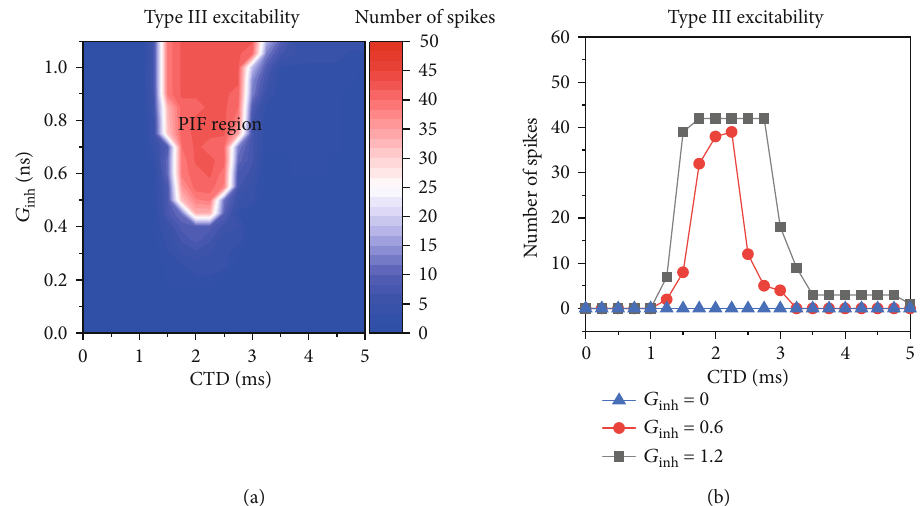
= 1 : 5 mS/cm 2 . (a) The fi ring rate on the Figure 9: The dependence of the PIF phenomenon on G inh and CTD for type III excitability when G ex parameter plane (CTD, G inh ); (b) the changes of the fi ring rate with increasing CTD at di ff erent G inh values. Blue, red, and black curves represent G inh = 0 , 0.6, and 1.2mS/cm 2 ,